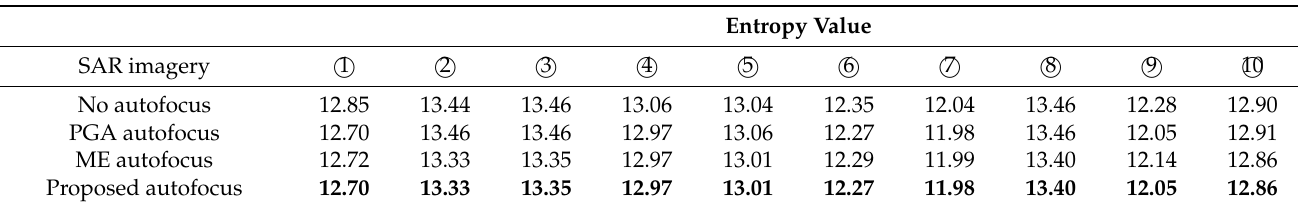
Table 4. Quality quantitative evaluation of the ten large imageries based on the entropy criterion. The threshold is 94% and VGGNet16 is